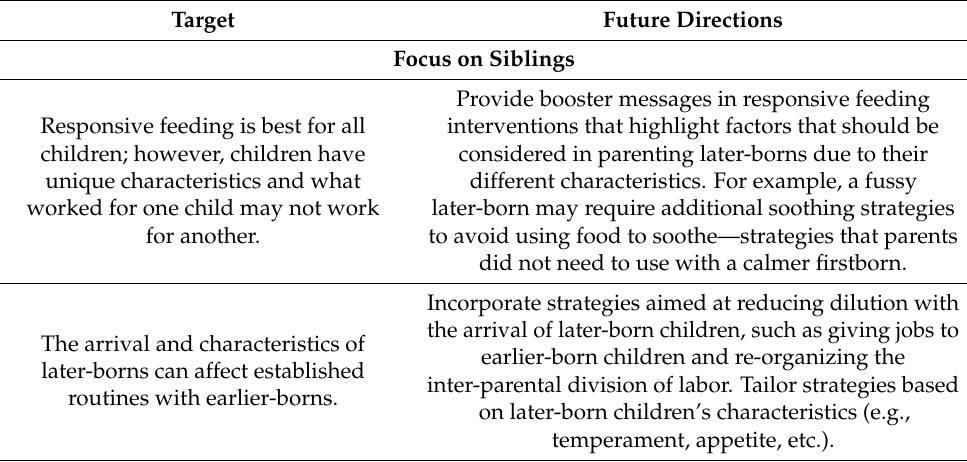
Table 1. Directions for future research and practice to address sibling influences on parental feed- ing